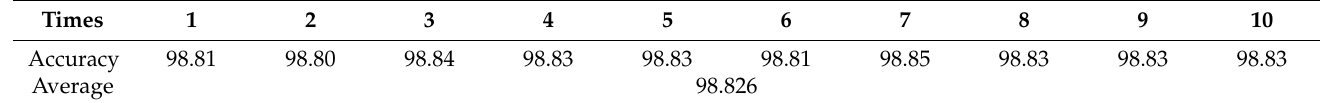
Table 11. Results and the average of 10 times 10-fold cross-validation.